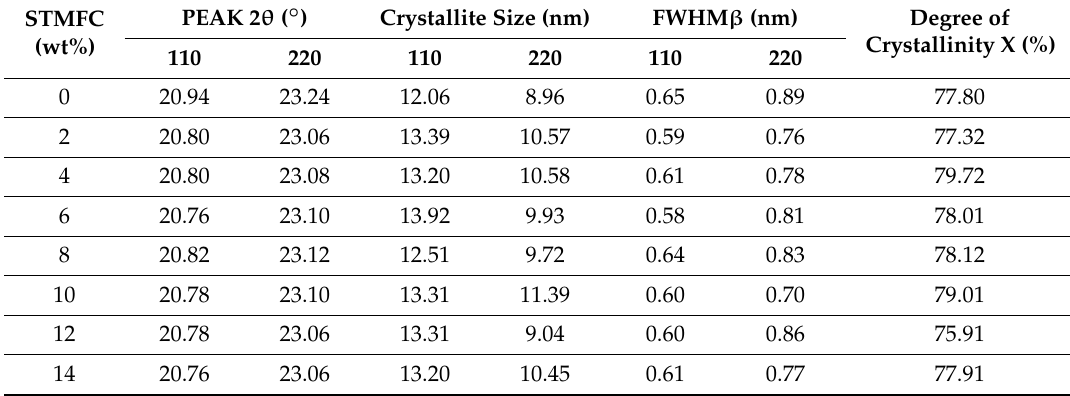
Table 2. Crystal parameters of the STMFC/LLDPE composite reinforced with different contents.